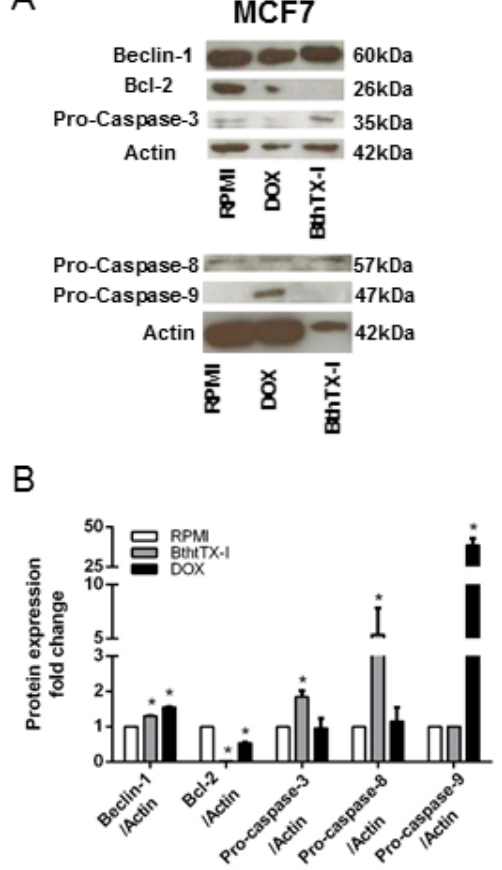
Figure 4. Beclin-1 and Bcl-2 protein ( A ) expression and ( B ) quantification in MCF7 cells treated with BthTX-I at 102 µg/mL for 24h. DOX: cells treated with doxorubicin at 4 µM (positive control). RPMI: cells incubated in estrogen- free RPMI 1640 medium supplemented with CS-FBS (negative control). * p < 0.05 vs negative control (Student’s t